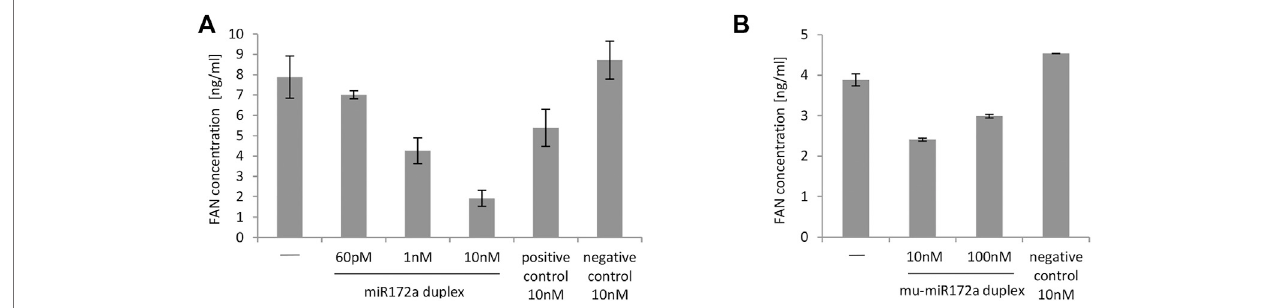
FIGURE 2 | Level of FAN protein in K21 cells (A) and MEFs (B) transfected with miR172a duplex at different concentrations. (A) MISSION microRNA mimics and siRNAHMC0003wereusedasnegativeandpositivecontrols,respectively.Inallcases,4 hbeforetheendoftheexperiment,LPSata fi nalconcentrationof1 μ g/mlwas addedtoeachwellonplates.The fi rstbaronthegraphrepresentsuntransfectedcellsinducedwithLPSinthesamewayascellstransfectedwiththemiR172aduplexor with controls. The FAN concentration was determined 48 h after transfection. (B) Nonspeci fi c dsRNA (customized siGENOME Nontargeting siRNA #3, Dharmacon)wasusedasanegativecontrol.Inallcases,4 hbeforetheendoftheexperiment, 1 ng/mlTNFwasaddedtoinduce thein fl ammatoryprocess. The fi rstbar on the graph represents cells not transfected with TNF in the same way as cells transfected with the mu_miR172a duplex and negative control. The FAN concentration was determined using dedicated ELISA Kits. The graphs show data obtained in single experiments with SD from ELISA measurements.